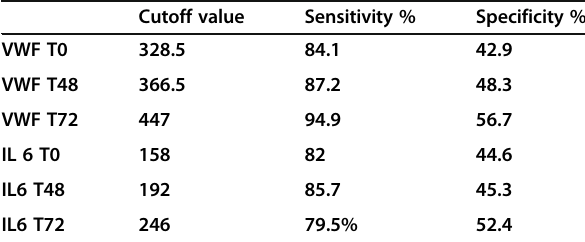
Table 4 Different cutoffs of vWF (% of normal) and IL6 (pg/ml) with their sensitivity and specificity for ARDS prediction during the study